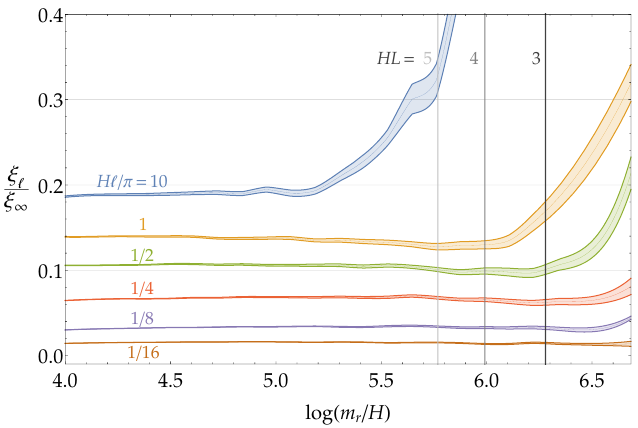
Figure 18 . (cid:24) ‘ =(cid:24) 1 for the set of simulations with H f L f = 2, for di(cid:11)erent values of ‘ . The shaded bands represent statistical errors in the average over di(cid:11)erent simulations. The other parameters are (cid:12)xed as m r a = 1 : 33 and a (cid:28) =a c = 1 =